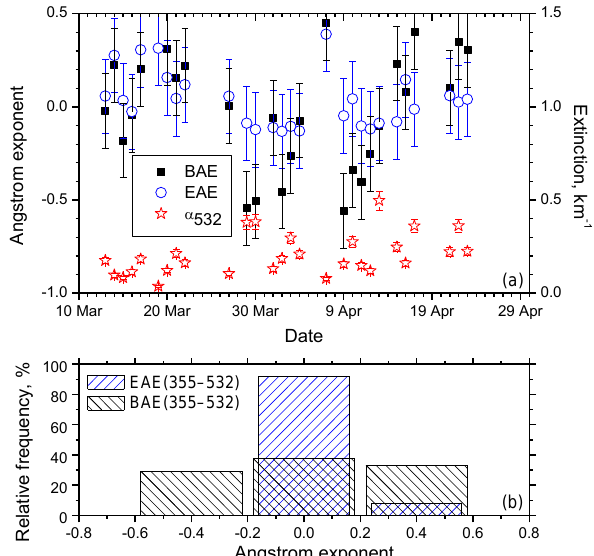
Figure 7. (a) Particle extinction coefficient at 532nm together with backscattering and extinction Ångström exponents at 355/532nm, derived from lidar measurements within the 1500–2000m layer for the period of March–April 2015. (b) Frequency distributions of BAE and EAE.